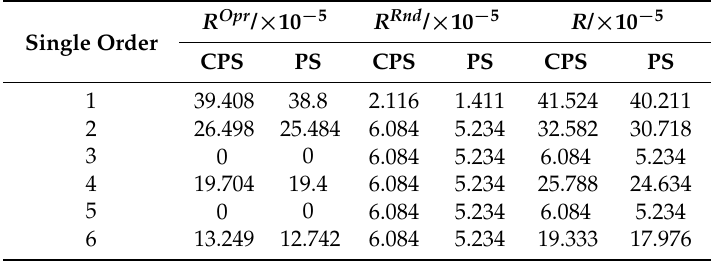
Table 4. Comparison of dispatching order risk in a CPS and a physical system